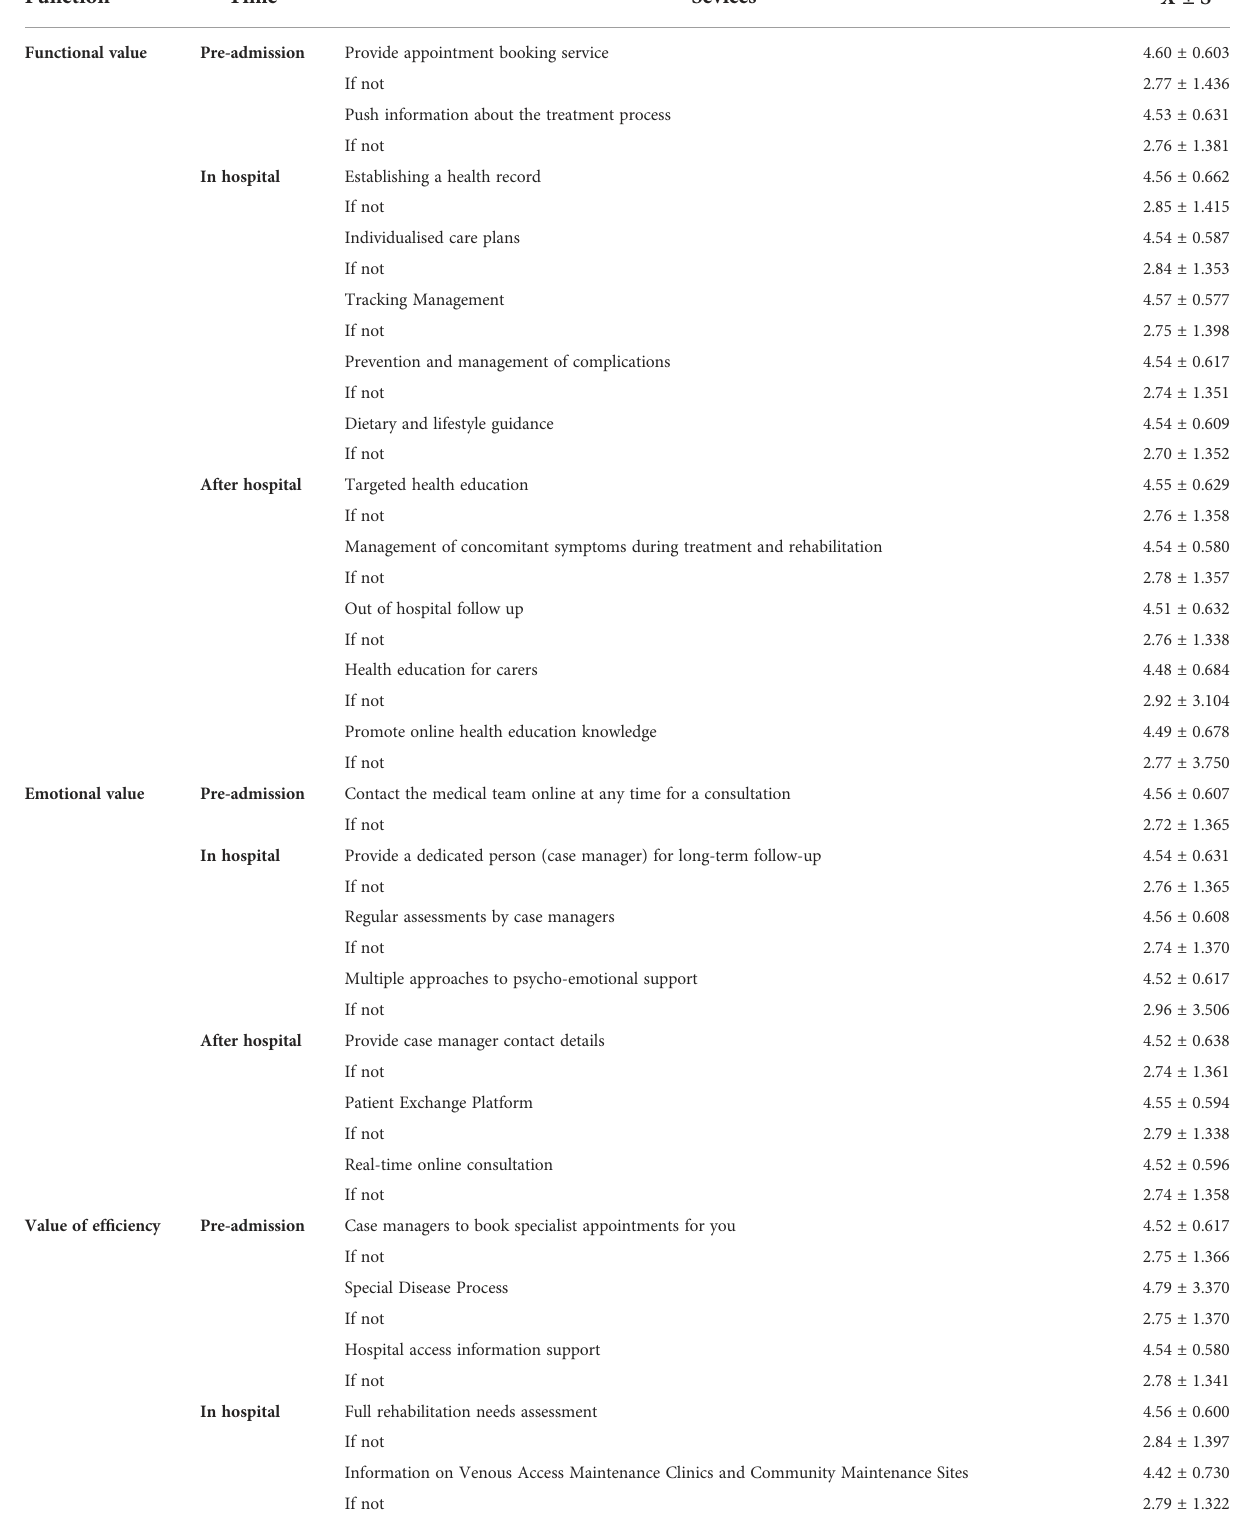
TABLE 1 Content needs and evaluation of the information management platform by breast cancer patients and family members. Function Time Sevices (cid:1) X ±